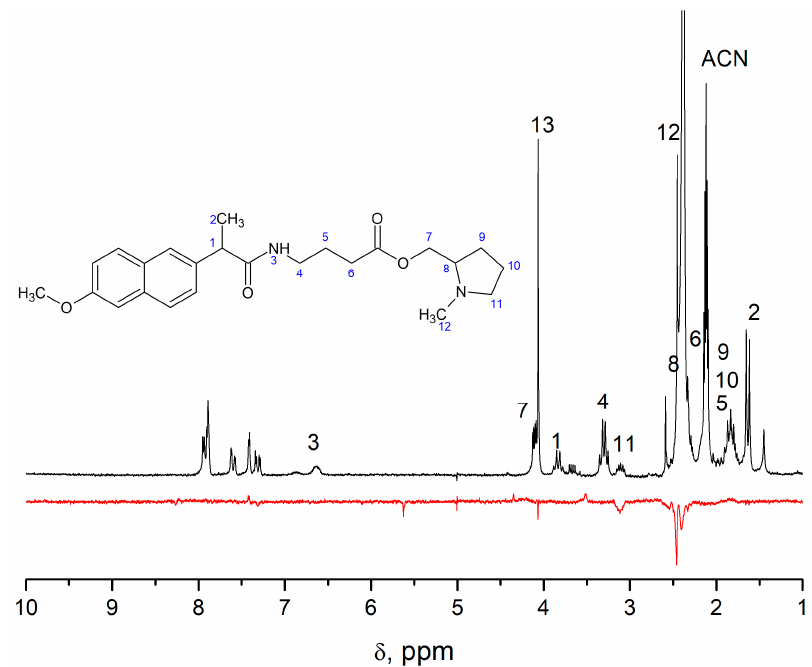
Figure 10. 1 H NMR (black) and CIDNP spectra (red) of 4 mM ( R,S )-I in CD 3 CN. NMR spectra of ( R,S )- and ( S,S )-I are identical. 1 H NMR and CIDNP spectra of three optical configurations ( R,S )-, ( S,R )-, and ( S,S